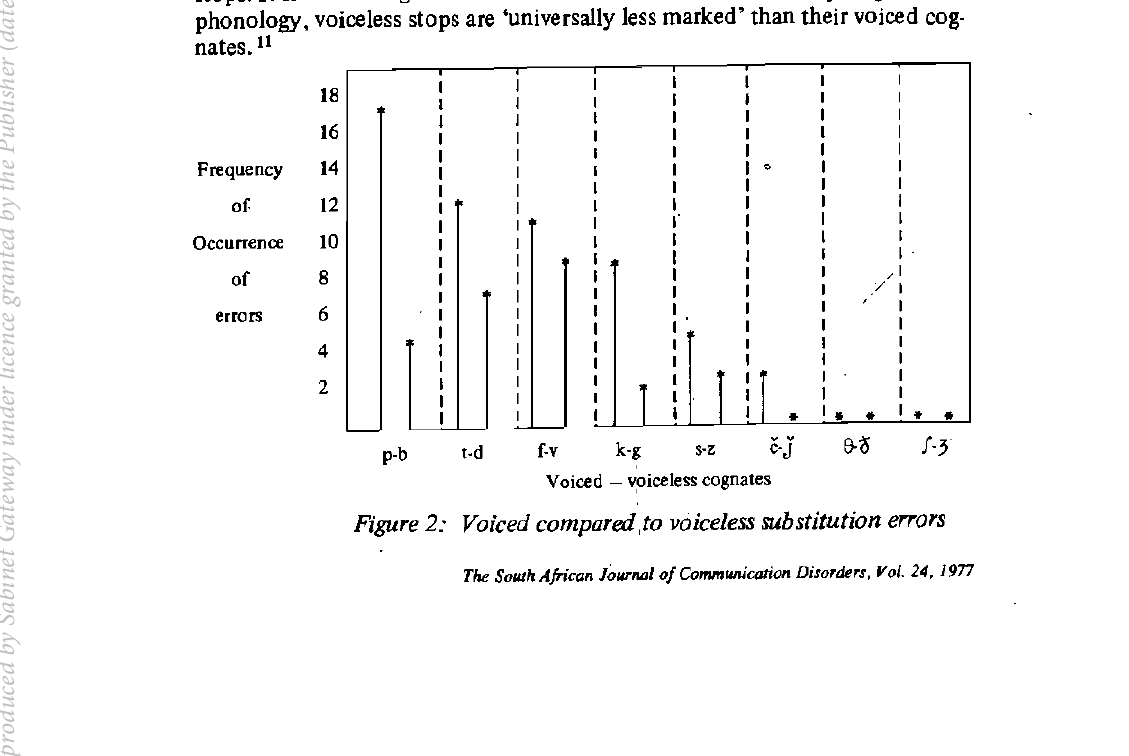
Figure 2: Voiced compared to voiceless substitution